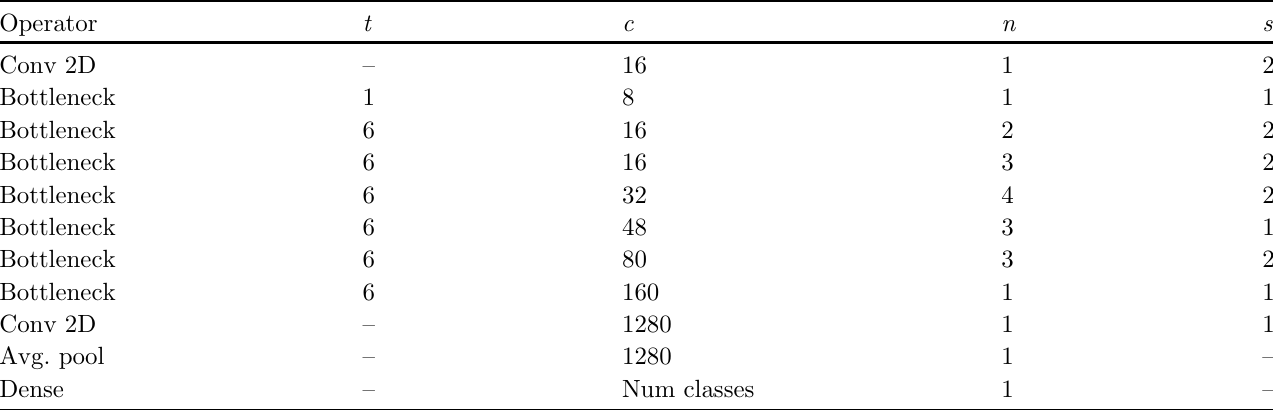
Table 3. MobileFaceNet network structure diagram.